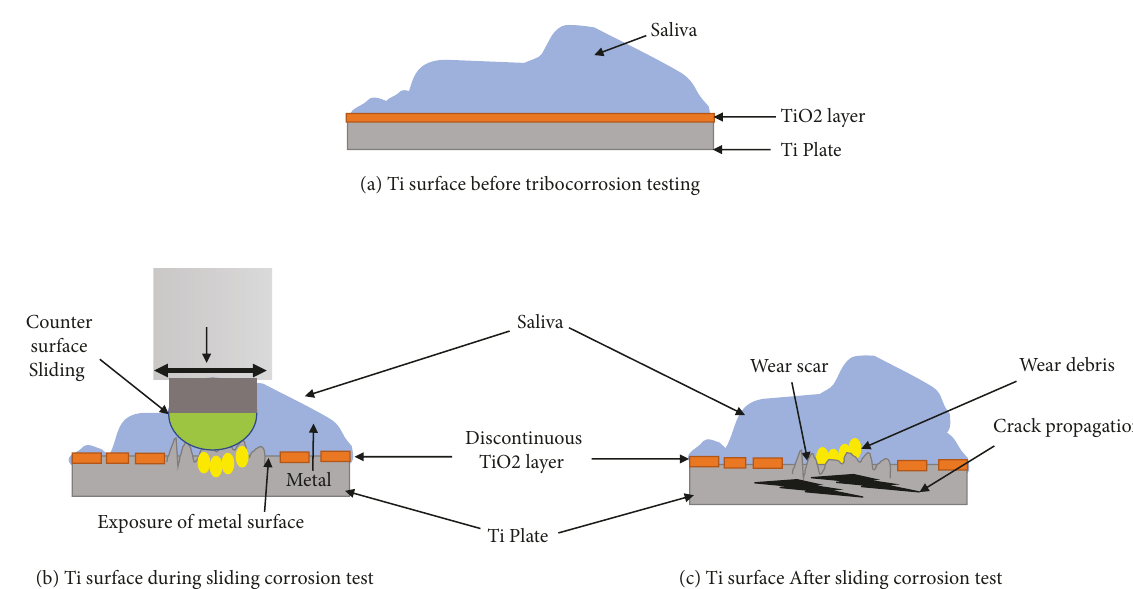
Figure 3: Structural changes in Ti surface following Tribocorrosion testing. (a) Ti surface before tribocorrosion testing. (b) Ti surface during sliding corrosion test. (c) Ti surface after sliding corrosion